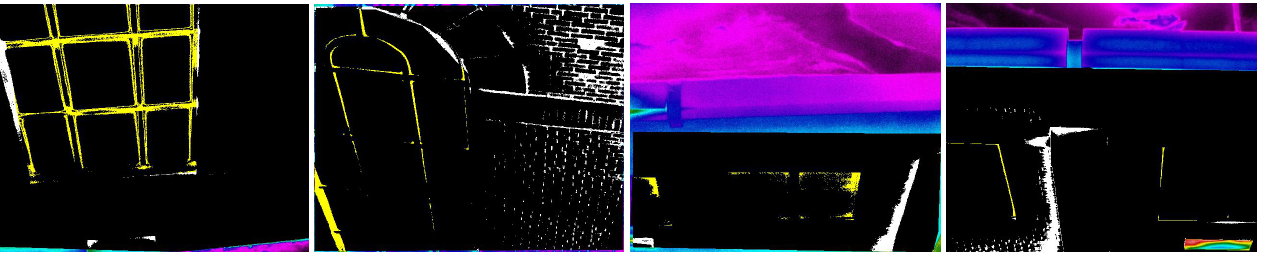
Figure 7. Raw ( a – d ) and hotspot ( e – l ) images for two particular windows of Museum and Twamley over the morning, afternoon, and evening.